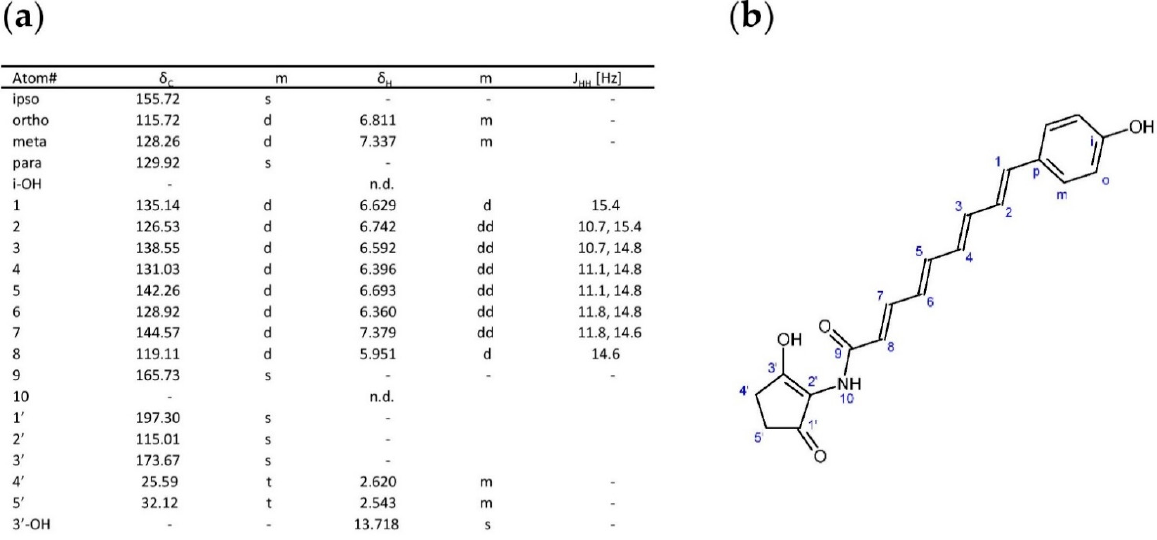
Figure 6. Pathway intermediate structure predicted by NMR. Measured for 1 H and 13 C at 700.13 MHz for 1 H and at 176.05 MHz for 13 C in CDCl 3 at 20 °C. ( a ) NMR data summary, ( b ) structure predicted.